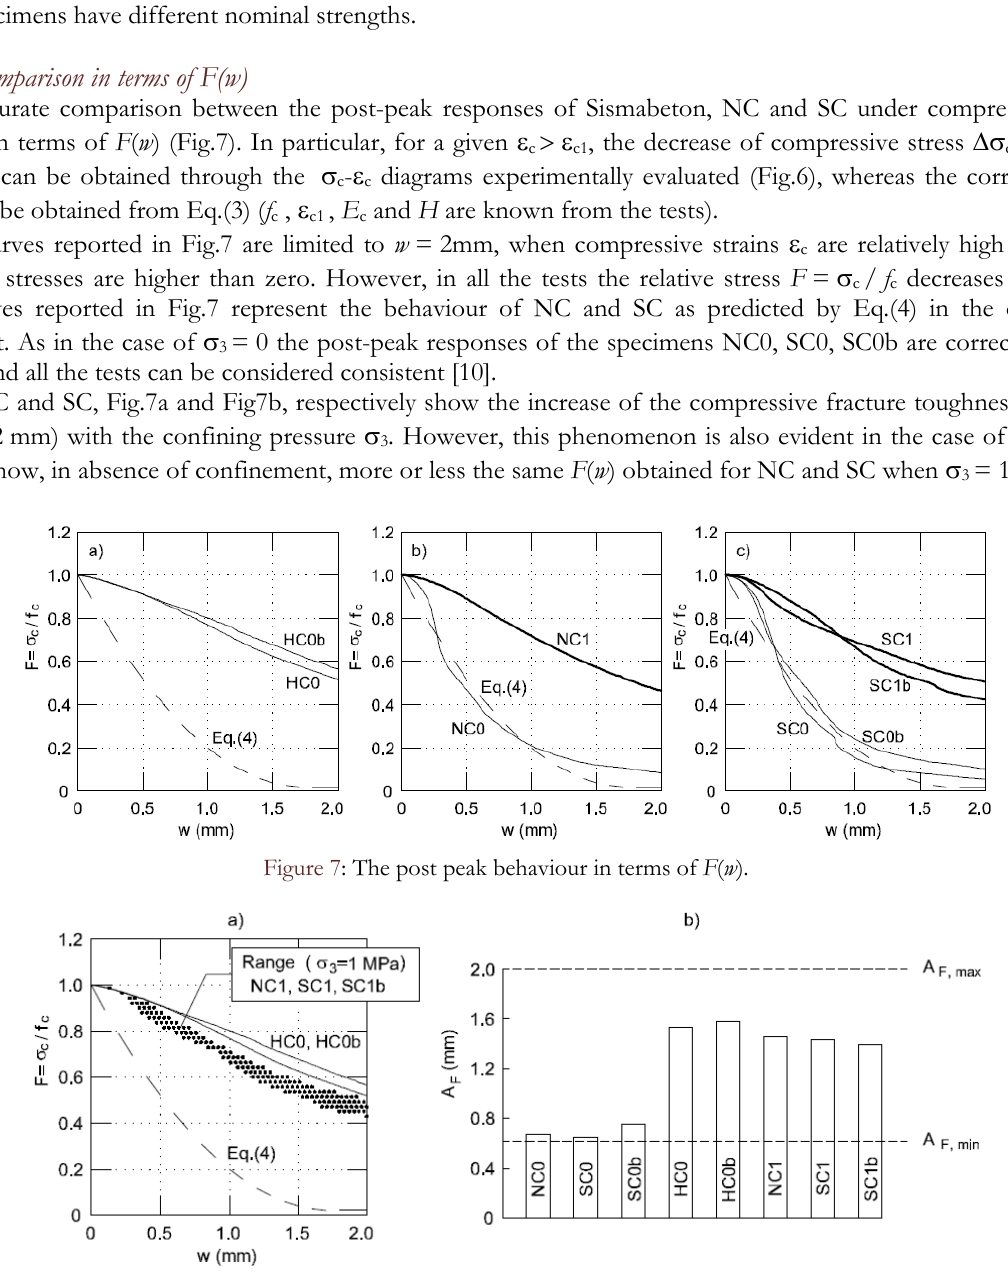
Figure 8: The active confinement of